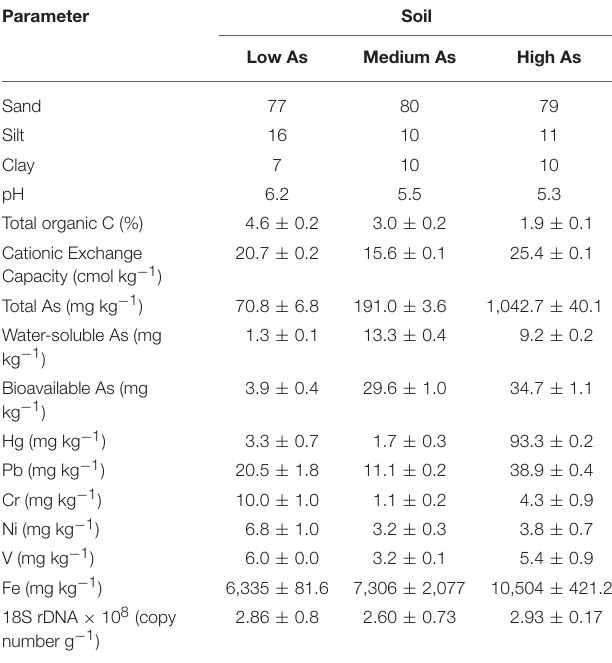
TABLE 1 | Main properties of the three soils from the Pestarena gold mine site. Parameter Soil Low As Medium As High